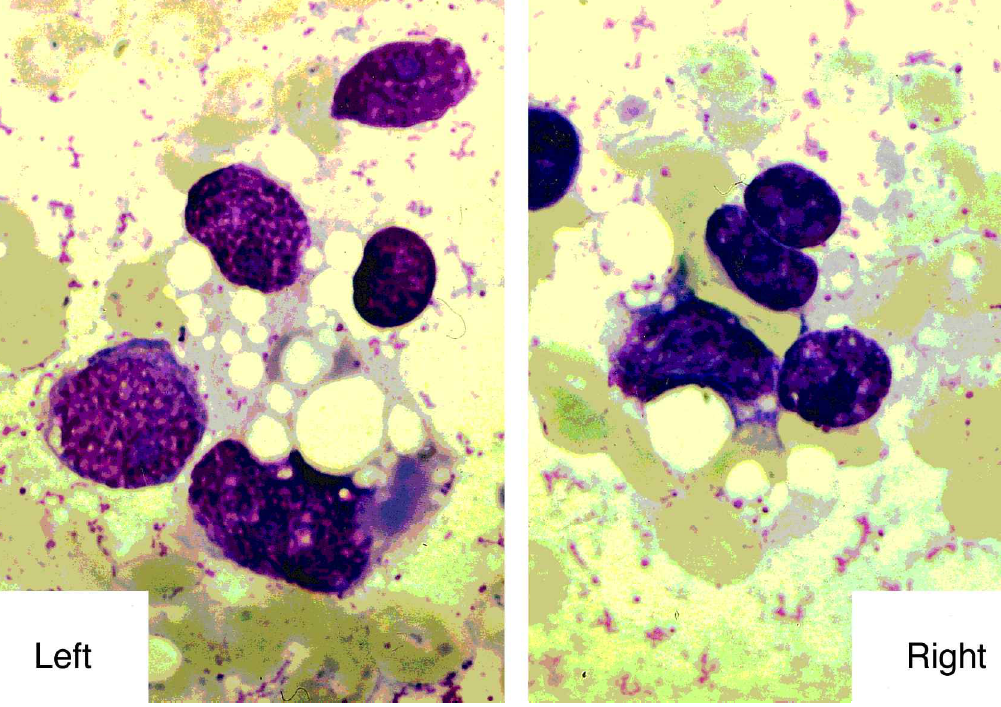
Fig. 3. Highly atypical lipoblasts in an aspirate from a pleomorphic liposarcoma . (MGG 3 1000)